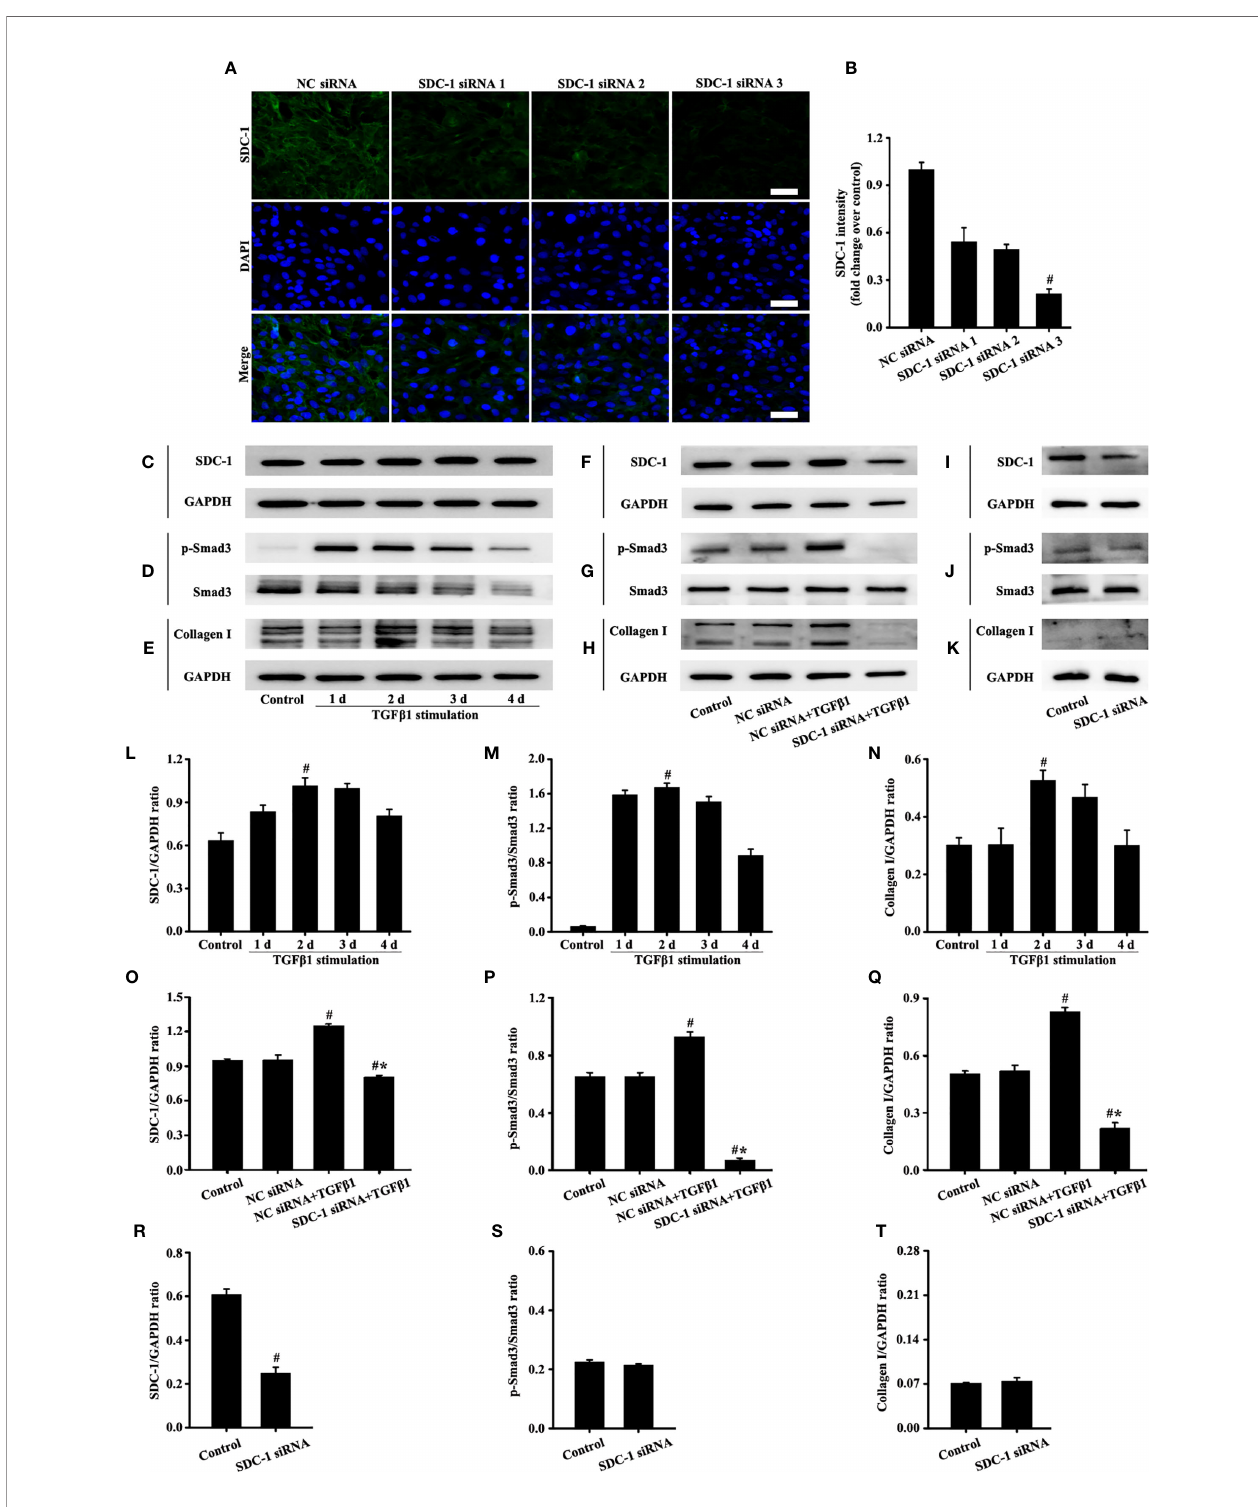
FIGURE 4 | Effects of SDC-1 siRNA on collagen I and p-Smad3 in Beas-2B cells were observed. Deletion effects of SDC-1 siRNA 1, SDC-1 siRNA 2, and SDC-1 siRNA 3 on SDC-1 expression (A) were detected by immuno fl uorescence. Changes in SDC-1 (C) , p-Smad3 (D) , and collagen I (E) under TGF b 1 stimulation at different periods were detected by Western blot. Effects of SDC-1 siRNA 3 on SDC-1 (F , I) , p-Smad3 (G , J) , and collagen I (H , K) were detected by Western blot. (B) SDC-1 immuno fl uorescence intensity analysis of (A) . (L – T) Protein intensity analysis of (C - K) , respectively. Data are shown as the means ± SD of three independent experiments. # p < 0.05 versus the control group. # *p < 0.05 versus the NC siRNA+TGF b 1